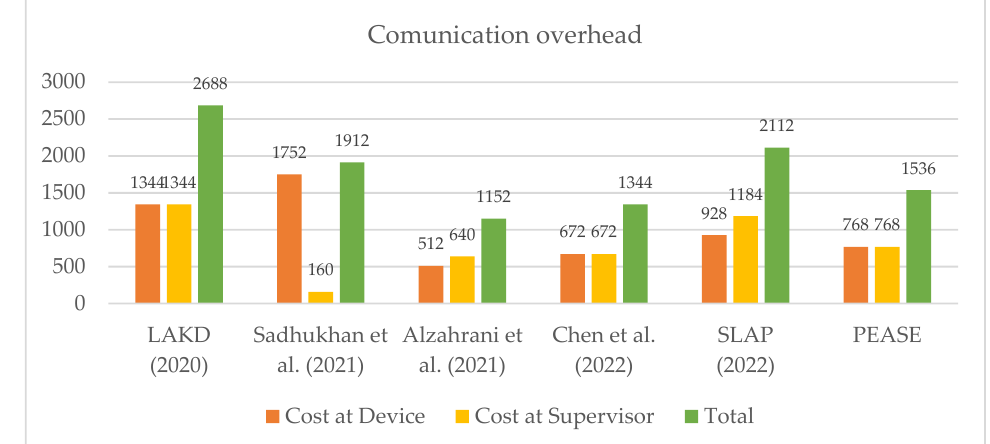
Figure 10. Performance comparison based on communication overhead.